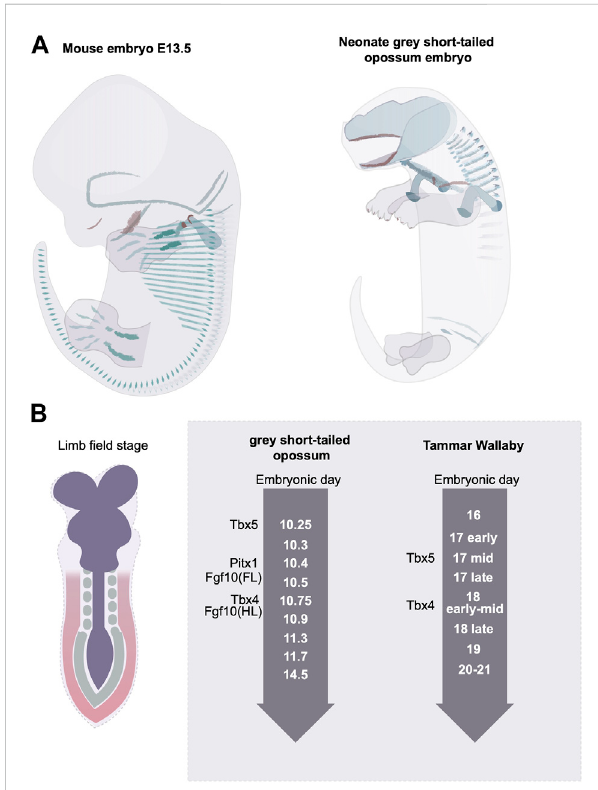
FIGURE 4 Rostral to caudal developmental heterochrony in mammalian embryos. (A) the grey short-tailed opossums display a severe rostral- to-caudal heterochrony marked by the reduced size in hindlimb and the lack of matured cartilage structure at the rostral end. Green indicates the differentiated cartilage and red labels the ossi fi ed bone structures. (B) The marsupial embryos display limb developmental heterochrony at the limb initiation